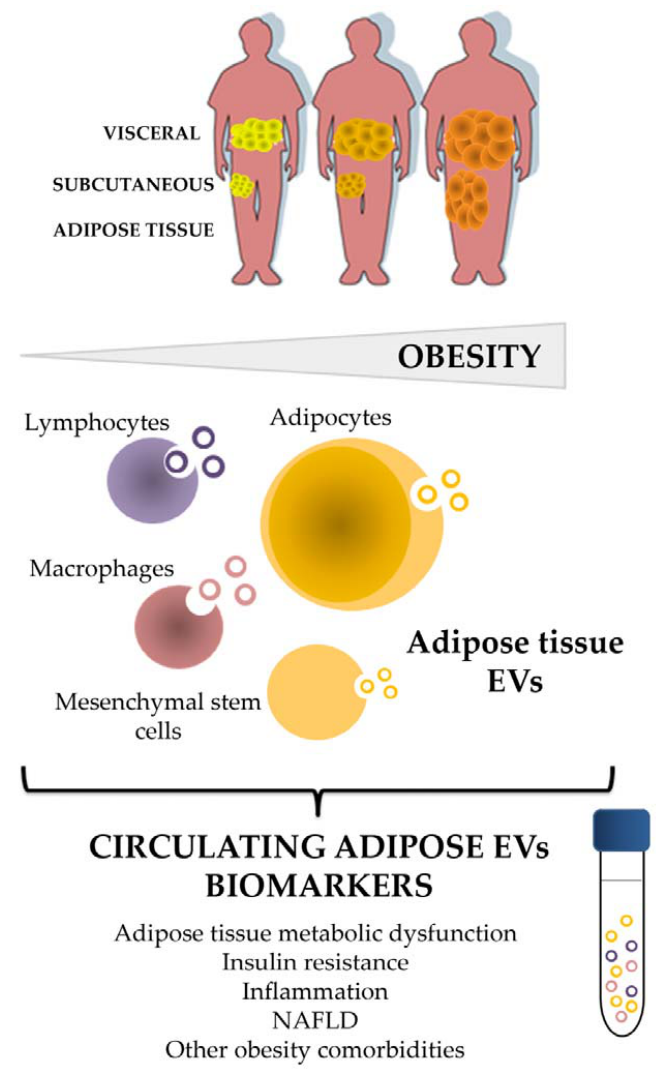
Figure 1. Adipose tissue and its cellular components shed EVs as an alternative way of communication at paracrine and endocrine level that reflects characteristics of the metabolic status, and emerge as a biomarker source of disease. EVs: extracellular vesicles; NAFLD: non-alcoholic fatty liver